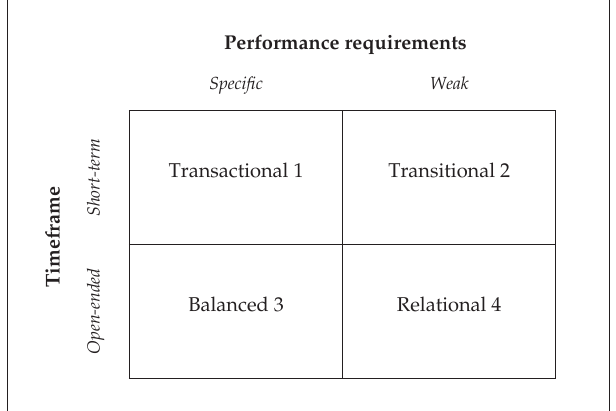
FIGURE 1: Types of psychological contracts (Rousseau, D.M., & Wade-Benzoni, K. (1994). Linking strategy and human resource practices: How employee and customer contracts are created. Human Resource Management Journal, 33 (3), 463–489.